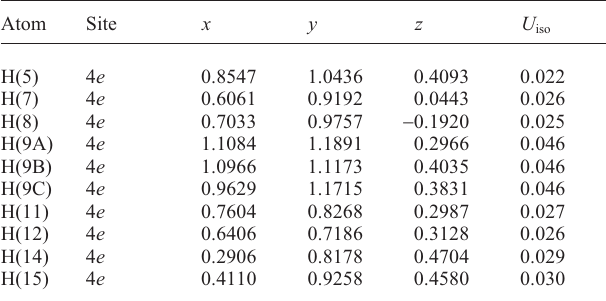
Table 2. Atomic coordinates and displacement parameters (in Å 2 )